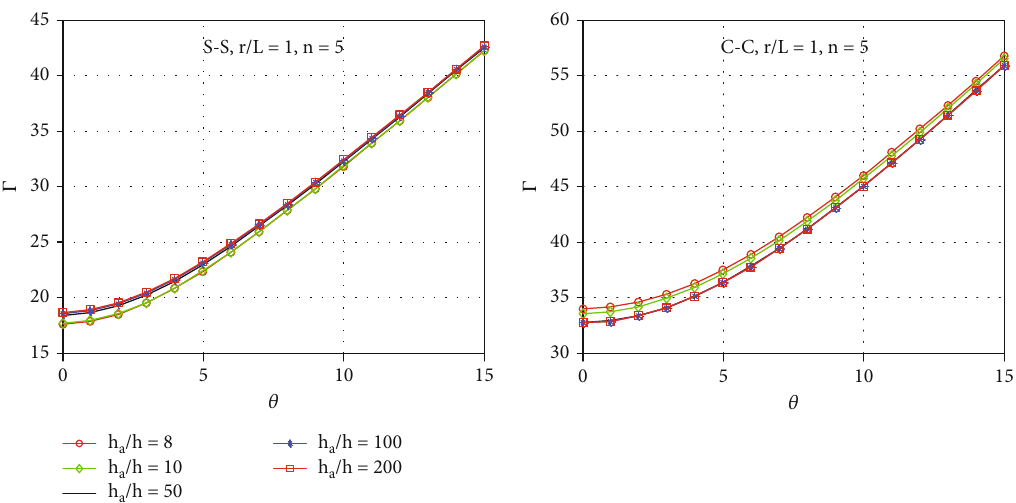
h and θ , r / L = 1 , and n = 5 a /